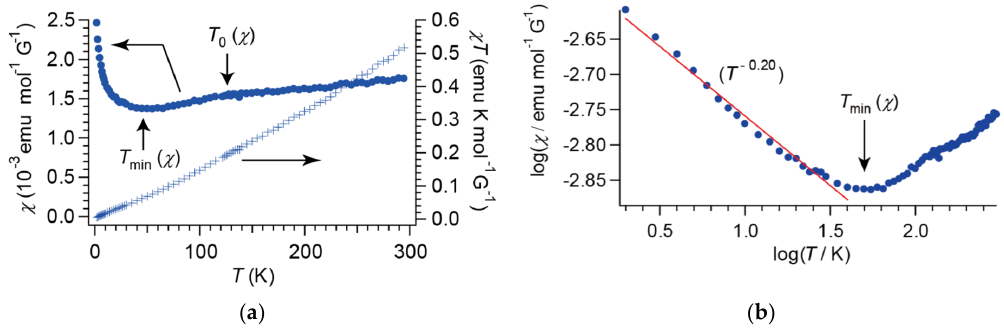
Figure 5. Temperature dependence of molar magnetic susceptibility of  -STF 2 I 3 (  ) at 2–300 K: ( a )  vs. T (blue filled circles) and  T vs. T (blue crosses); ( b ) log  vs. log T (blue filled circles) and the best vs. T (blue filled circles) and χ T vs. T (blue crosses); ( b ) log χ vs. log T (blue filled circles) and the best fitting line (red) at 2–40 K, respectively. fitting line (red) at 2–40 K,